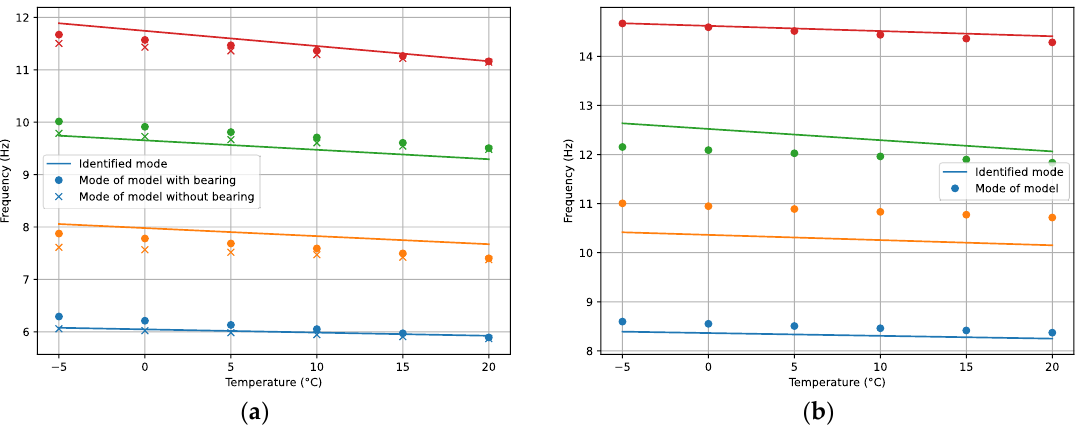
Figure 13. Variation patterns of natural frequencies according to temperature in updated models: ( a ) Seolmun Bridge; ( b ) Gajwa Bridge.